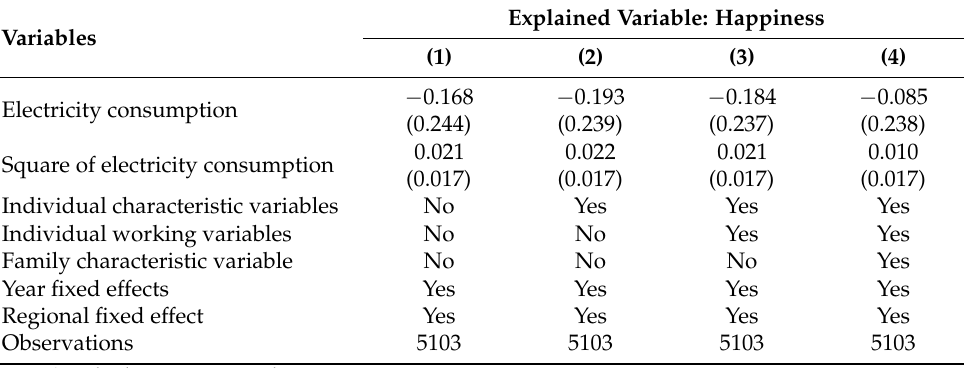
Table 10. Further analysis: test of nonlinear effect.